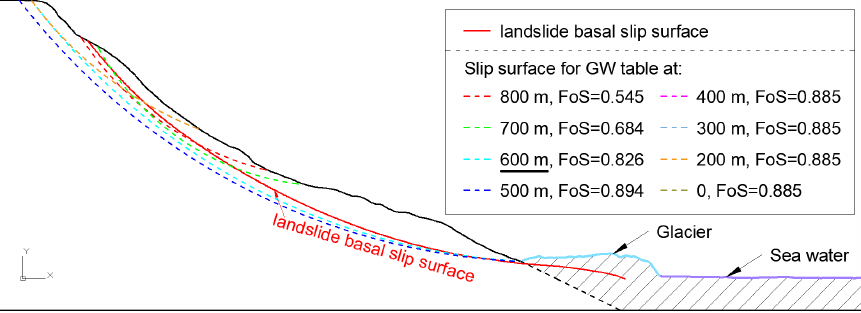
Figure 8. Sliding surfaces for different levels of the groundwater table under the seismic acceleration of 0.3 g (the slip surface corresponding to the GW table with black underlines in the legend is closest to the observed slip surface).